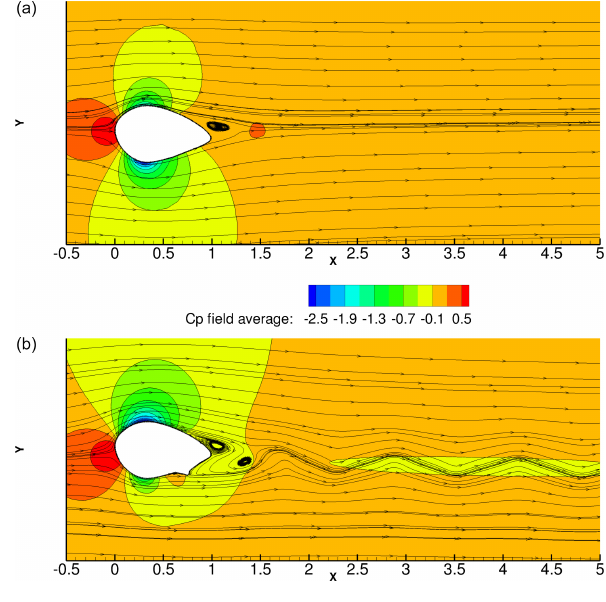
Figure 4. Average pressure field contour plot and instantaneous ve- locity streamlines for α = 6 ◦ and Re c = 3 × 10 6 : (a) no spoiler case and (b) spoiler